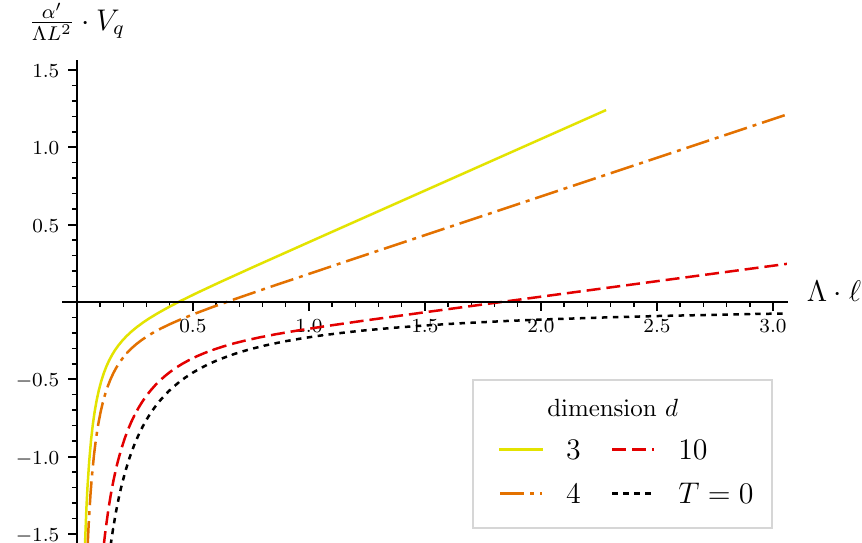
Figure 6. Quark-antiquark